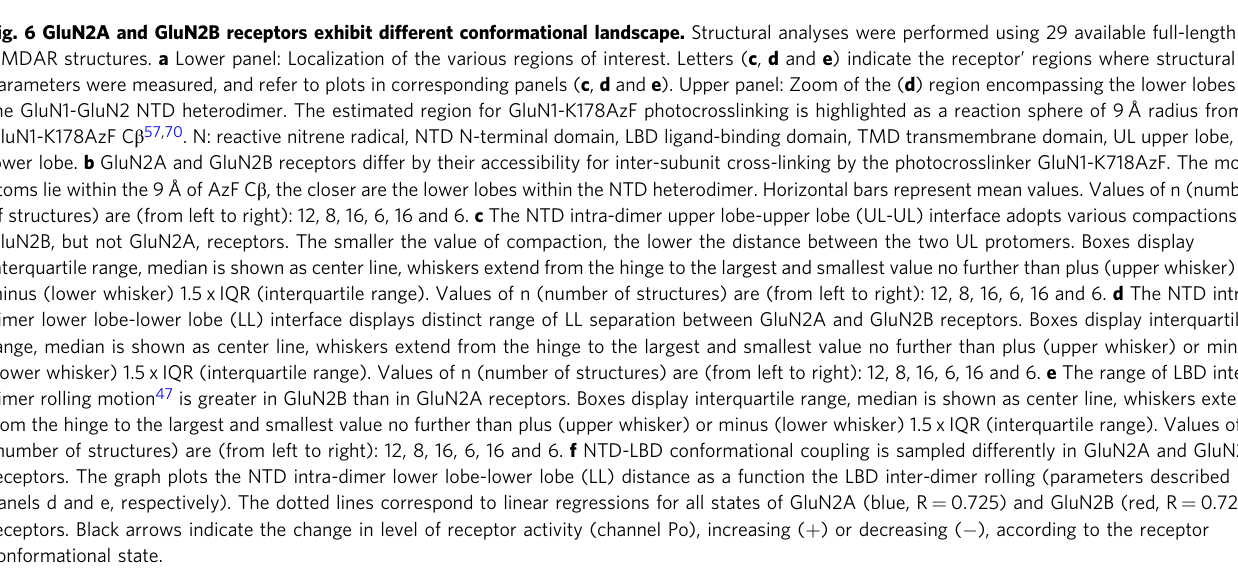
Fig. 6 GluN2A and GluN2B receptors exhibit different conformational landscape. Structural analyses were performed using 29 available full-length NMDAR structures. a Lower panel: Localization of the various regions of interest. Letters ( c , d and e ) indicate the receptor ’ regions where structural parameters were measured, and refer to plots in corresponding panels ( c , d and e ). Upper panel: Zoom of the ( d ) region encompassing the lower lobes of the GluN1-GluN2 NTD heterodimer. The estimated region for GluN1-K178AzF photocrosslinking is highlighted as a reaction sphere of 9 Å radius from GluN1-K178AzF C β 57,70 . N: reactive nitrene radical, NTD N-terminal domain, LBD ligand-binding domain, TMD transmembrane domain, UL upper lobe, LL lower lobe. b GluN2A and GluN2B receptors differ by their accessibility for inter-subunit cross-linking by the photocrosslinker GluN1-K718AzF. The more atoms lie within the 9 Å of AzF C β , the closer are the lower lobes within the NTD heterodimer. Horizontal bars represent mean values. Values of n (number of structures) are (from left to right): 12, 8, 16, 6, 16 and 6. c The NTD intra-dimer upper lobe-upper lobe (UL-UL) interface adopts various compactions in GluN2B, but not GluN2A, receptors. The smaller the value of compaction, the lower the distance between the two UL protomers. Boxes display interquartile range, median is shown as center line, whiskers extend from the hinge to the largest and smallest value no further than plus (upper whisker) or minus (lower whisker) 1.5 x IQR (interquartile range). Values of n (number of structures) are (from left to right): 12, 8, 16, 6, 16 and 6. d The NTD intra- dimer lower lobe-lower lobe (LL) interface displays distinct range of LL separation between GluN2A and GluN2B receptors. Boxes display interquartile range, median is shown as center line, whiskers extend from the hinge to the largest and smallest value no further than plus (upper whisker) or minus (lower whisker) 1.5 x IQR (interquartile range). Values of n (number of structures) are (from left to right): 12, 8, 16, 6, 16 and 6. e The range of LBD inter- dimer rolling motion 47 is greater in GluN2B than in GluN2A receptors. Boxes display interquartile range, median is shown as center line, whiskers extend from the hinge to the largest and smallest value no further than plus (upper whisker) or minus (lower whisker) 1.5 x IQR (interquartile range). Values of n (number of structures) are (from left to right): 12, 8, 16, 6, 16 and 6. f NTD-LBD conformational coupling is sampled differently in GluN2A and GluN2B receptors. The graph plots the NTD intra-dimer lower lobe-lower lobe (LL) distance as a function the LBD inter-dimer rolling (parameters described in panels d and e, respectively). The dotted lines correspond to linear regressions for all states of GluN2A (blue, R = 0.725) and GluN2B (red, R = 0.729) receptors. Black arrows indicate the change in level of receptor activity (channel Po), increasing ( + ) or decreasing ( − ), according to the receptor conformational